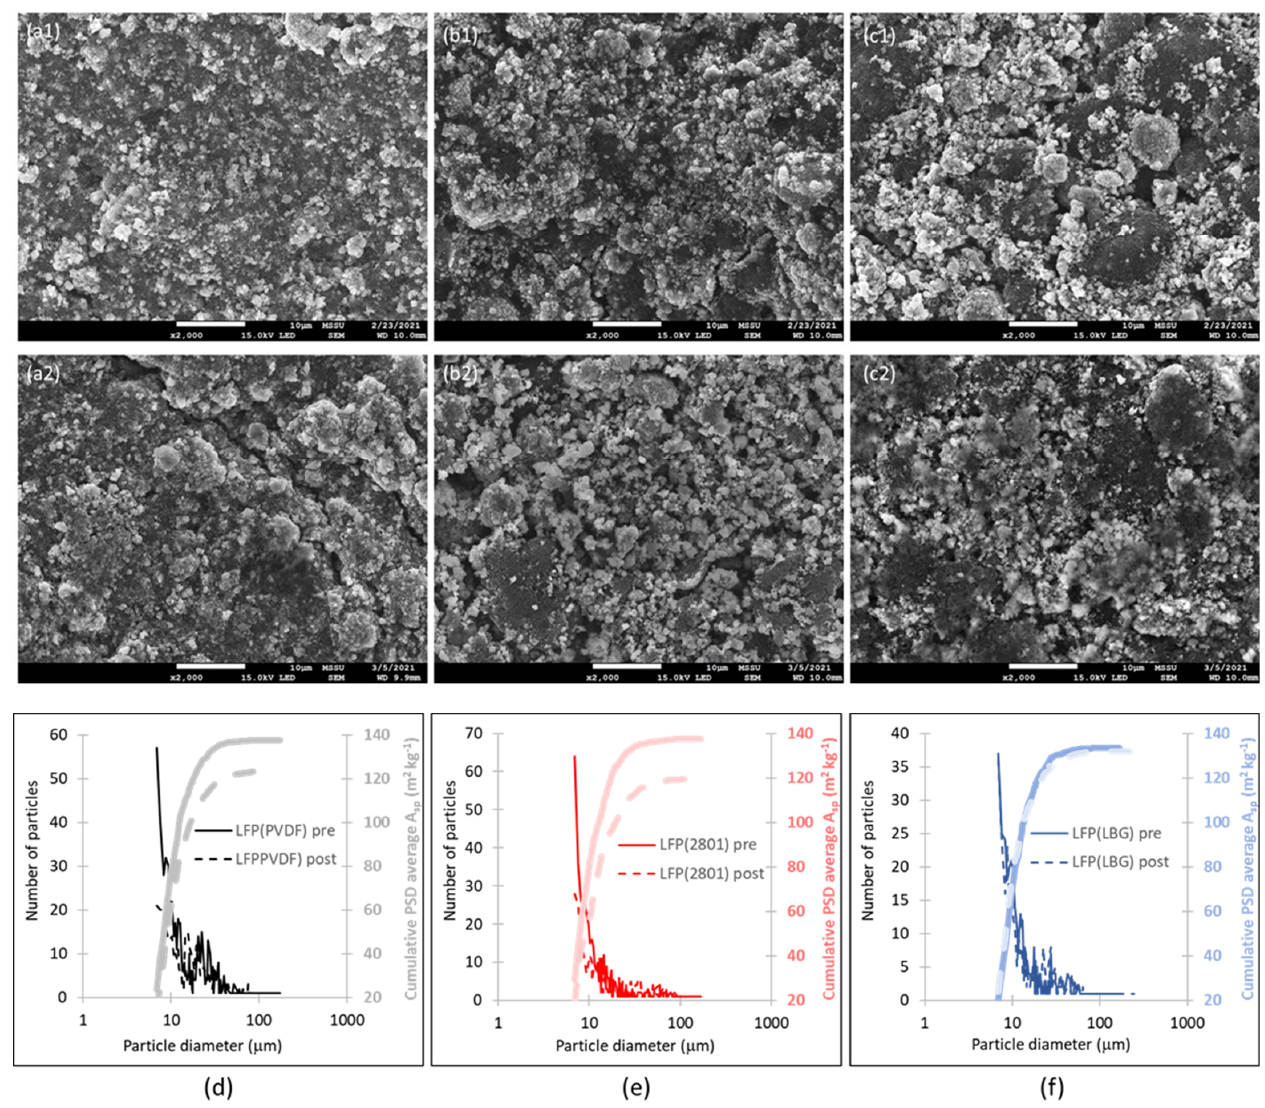
Figure 2. SEM micrographs of coatings as prepared (second index: 1) and postmortem after 25 battery cell cycles (second index: 2). First index: ( a ): PVDF binder; ( b ): KynarFlex ® PVDF 2801-00 binder; ( c ): Kynar PowerFlex ® LBG binder. Graphs of particle size distribution (PSD) of each coating (( d ): with PVDF binder, ( e ) with KynarFlex ® PVDF 2801-00 binder, ( f ) with Kynar PowerFlex ® LBG binder) as prepared before any battery cycling (solid lines) and postmortem after 25 battery cycles (broken lines); in each graph, thin lines show PSDs in terms of number of particles on left hand side axis, and wide lines of lighter color show cumulative PSDs in terms of specific area on the right hand side axis.